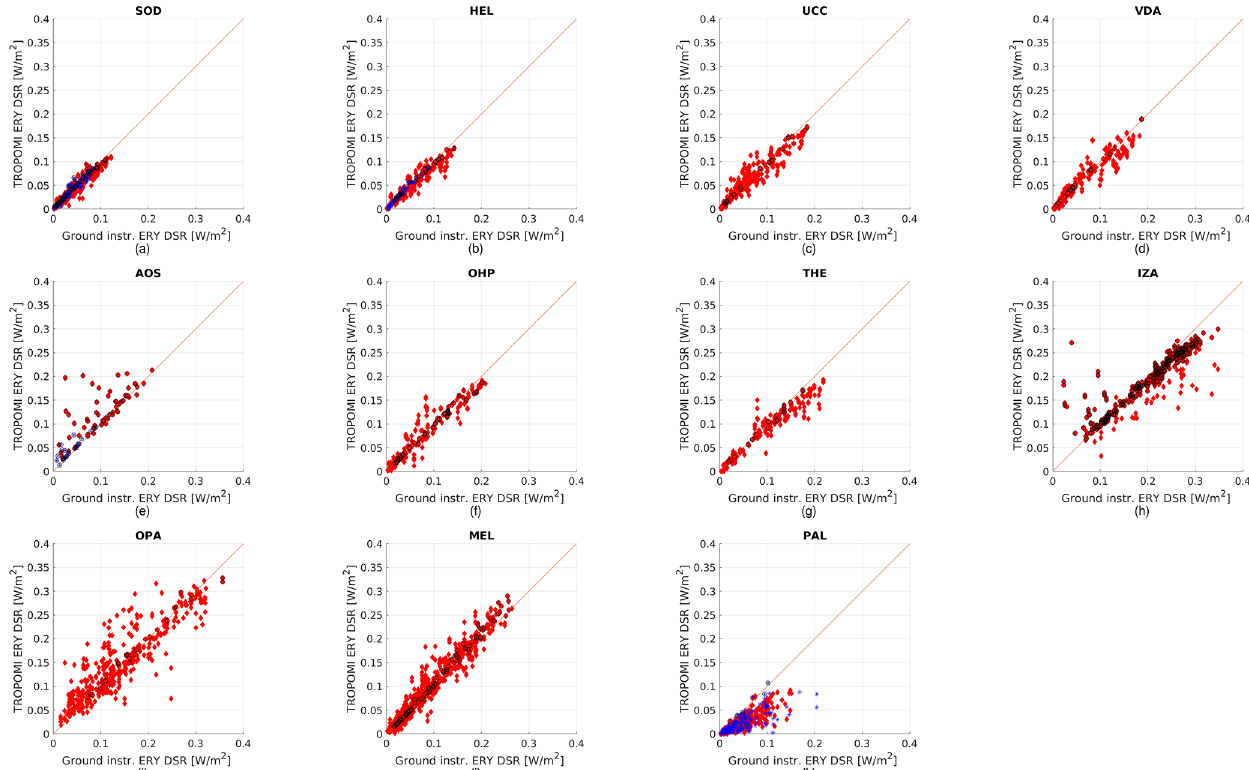
Figure 3. Erythemally weighted dose rates from spectroradiometer measurements and retrieved from satellite overpass at (a) Sodankylä, (b) Helsinki, (c) Uccle, (d) Villeneuve d’Ascq, (e) Aosta, (f) Haute-Provence, (g) Thessaloniki, (h) Izaña, (i) Saint-Denis, (j) Melbourne and (k) Palmer. The red diamond denotes a snow-free surface, the blue star snow cover and the black circle cloud-free